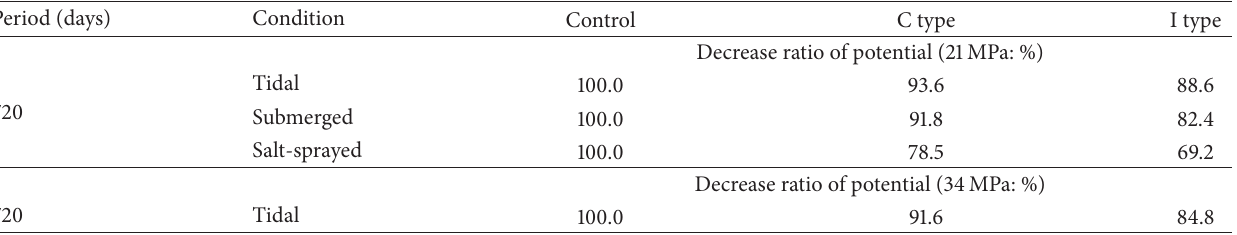
Figure 9: Derived apparent diffusion coefficient and surface chloride contents. Table 7: Decrease ratio of electrical potential after 2